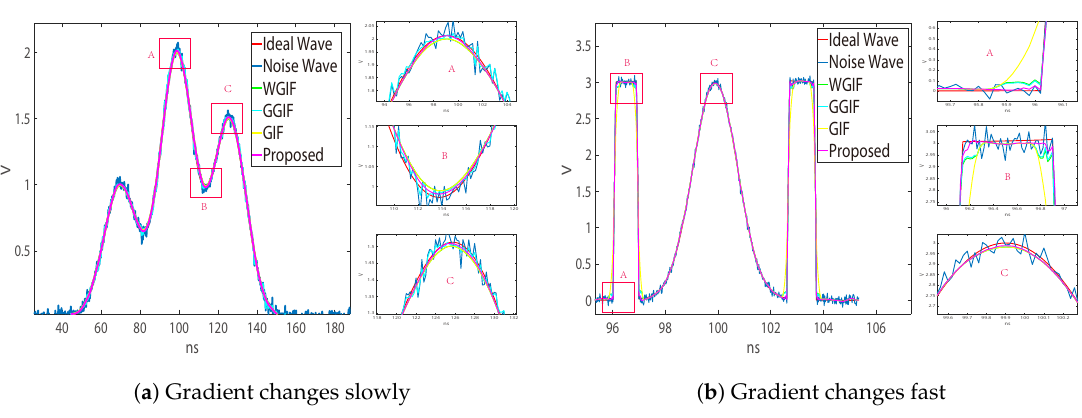
Figure 2. Comparison of the filtering effect. ( a ) Signal to noise ratio (SNR) = 25, f p = 5G, ψ = 300. δ = 7, variance = 0.01955 in weighted guided image filtering (WGIF). δ = 7, variance = 0.09954 in gradient domain guided image filter (GGIF). δ = 7, variance = 0.01987 in GIF. δ = 6–8, variance = 0.02107 in adaptive gradient-guided filtering (AGGF). ( b ) f p = 5G, SNR = 35, ψ = 67. δ = 5, variance = 0.01955 in WGIF. δ = 5, variance = 0.09954 in GGIF. δ = 5, variance = 0.01987 in GIF. δ = 5–7, variance = 0.02107 in